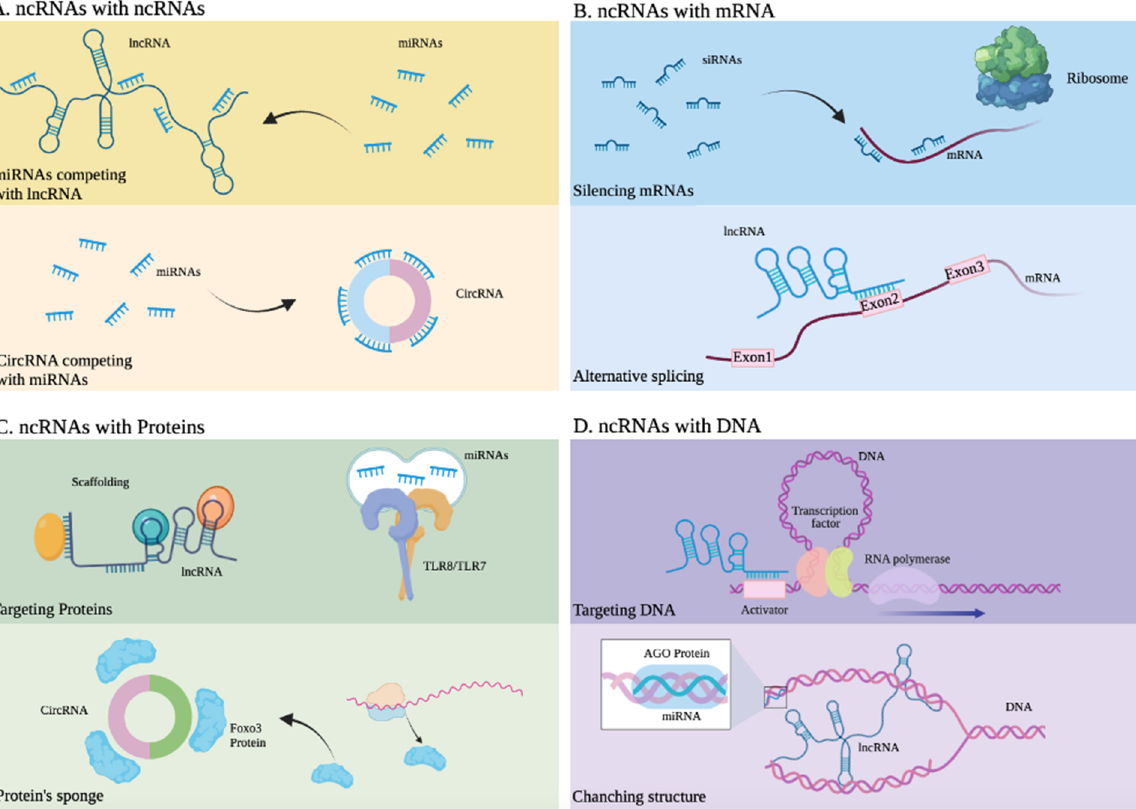
Figure 3. Interactions between noncoding RNAs and other molecules. ( A ) ncRNAs with other ncRNAs. Upper: miRNAs competing with lncRNA. Lower: CircRNA competing with miRNAs. ( B ) ncRNAs with mRNA. Upper: siRNAs silencing mRNA. Lower: Alternative splicing of mRNA due to an lncRNA. ( C ) ncRNAs with proteins. Upper: An lncRNA developing scaffold function and miRNAs activating Toll-like receptors. Lower: A circRNA serving as a sponge or Foxo3 protein. ( D ) ncRNAs with DNA. Upper: An lncRNA targeting the activator of a gene. Lower: An lncRNA altering the structure of DNA.